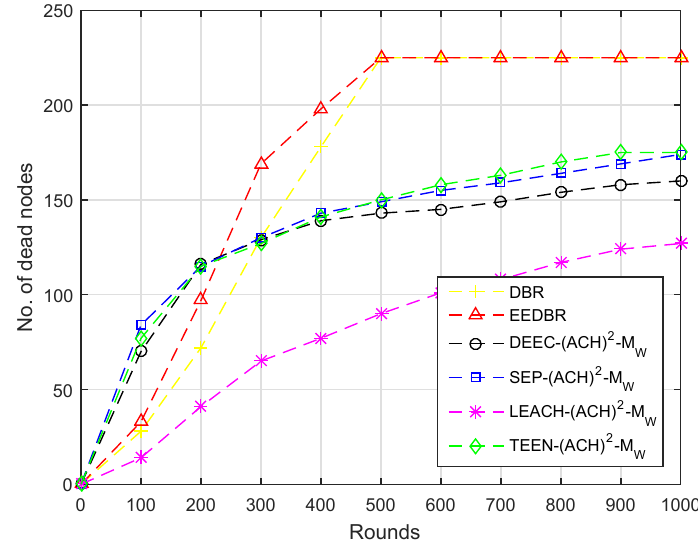
Figure 9. Number of Dead Nodes.